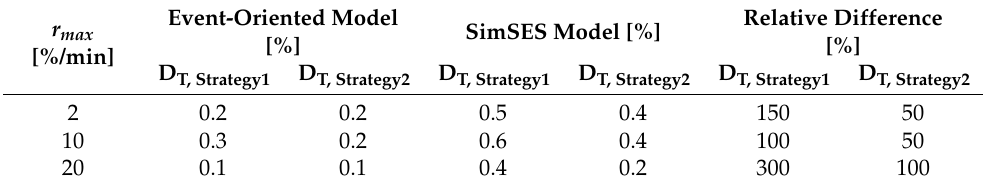
Table 3. Degradation comparison for different